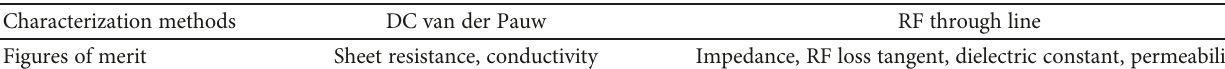
Table 5: Thin fi lm electrical